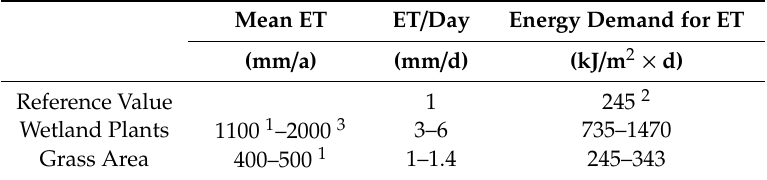
Table 3. Mean evapotranspiration capacity (ET) and resulting calculated daily ET and energy demand of di ff erent types of